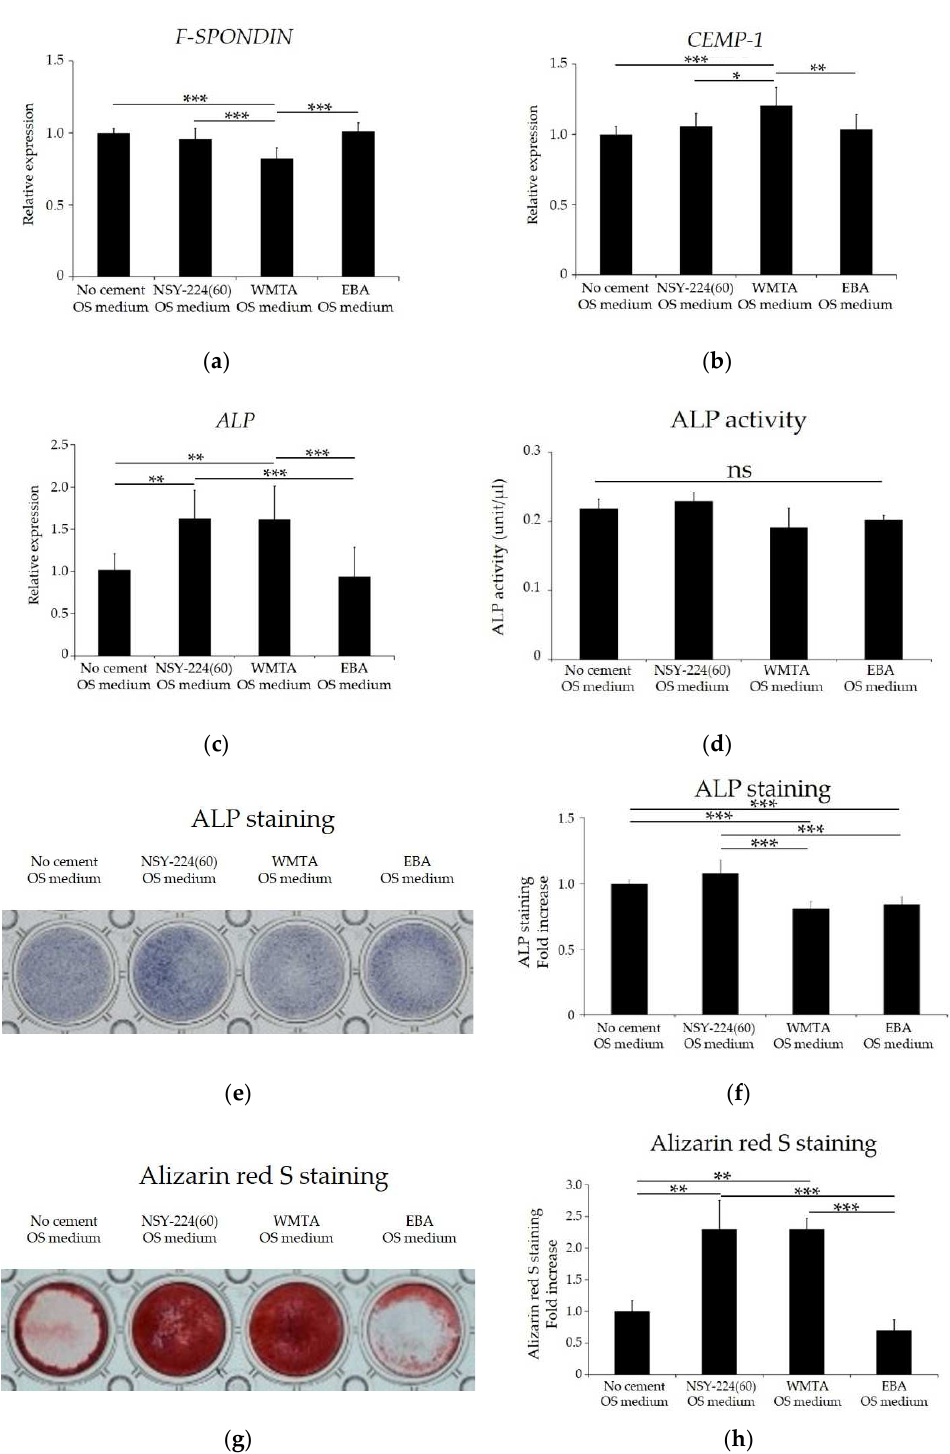
Figure 3. Effects of cements on morphology, viability, proliferation, and apoptosis of HCEMs. ( a , c ) Phase-contrast images of HCEMs cultured with each cement for 72 h. ( b ) Effect of mixing ratio of NSY-224 on the number of viable cells. ( d ) Effect of various materials on the number of viable cells. ( e , f ) Fluorescent images of Ki-67 ( e ) or Caspase3 ( f ) positive immunostaining in cells cultured with each cement for 60 h. Scale bars, 500 µm. The data are expressed as means ± SDs ( n = 3); ns: not significant; * p < 0.05 , ** p < 0.01 , *** p < 0.001.